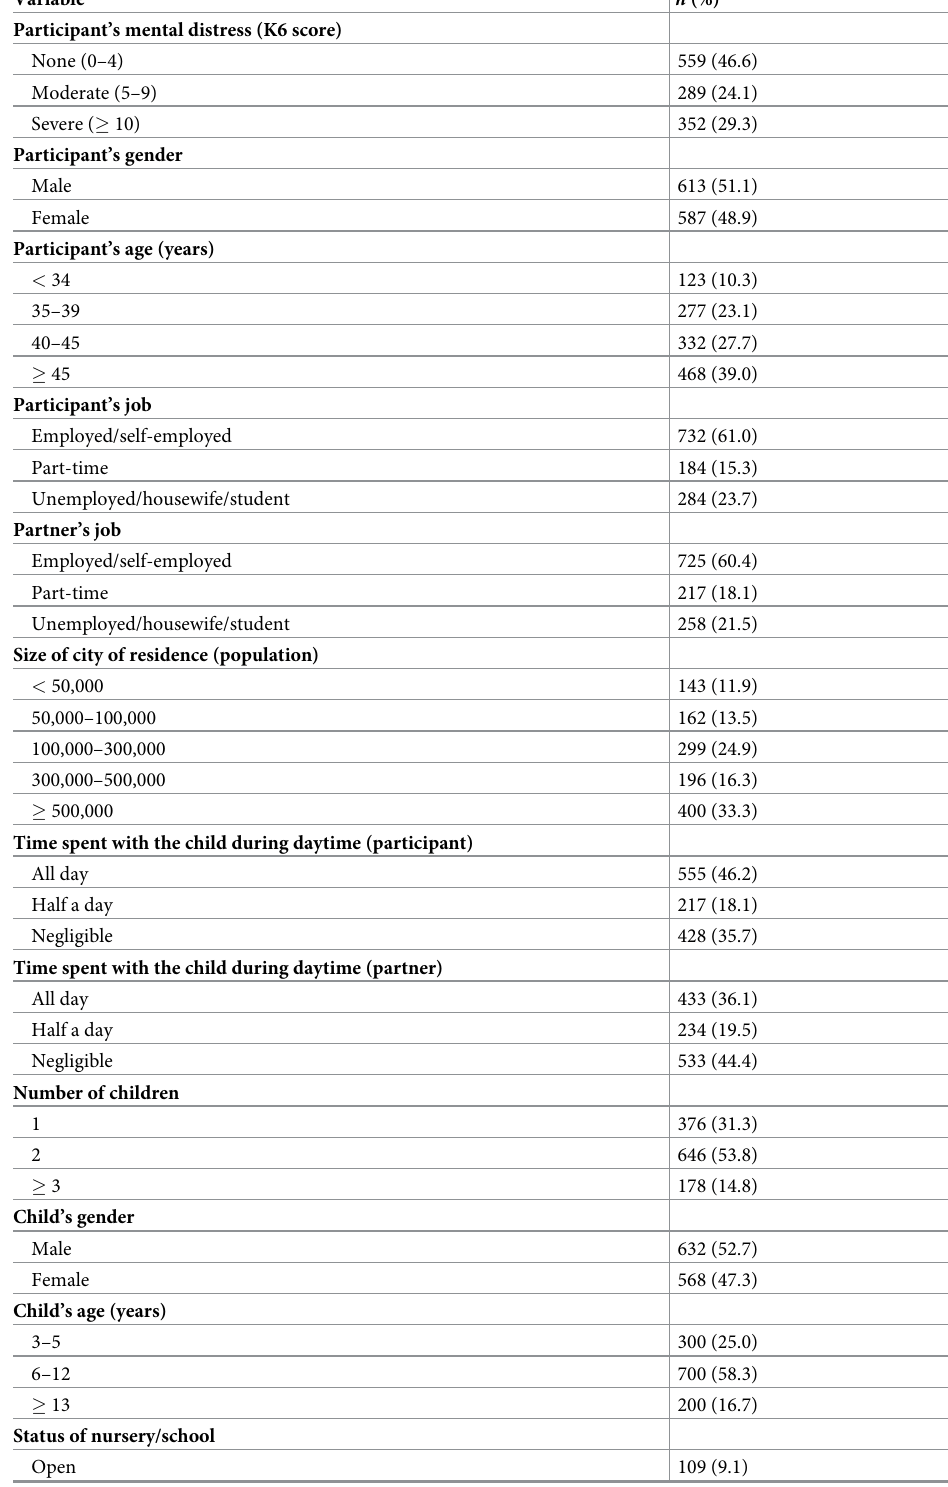
Table 1. Characteristics of study participants ( N =